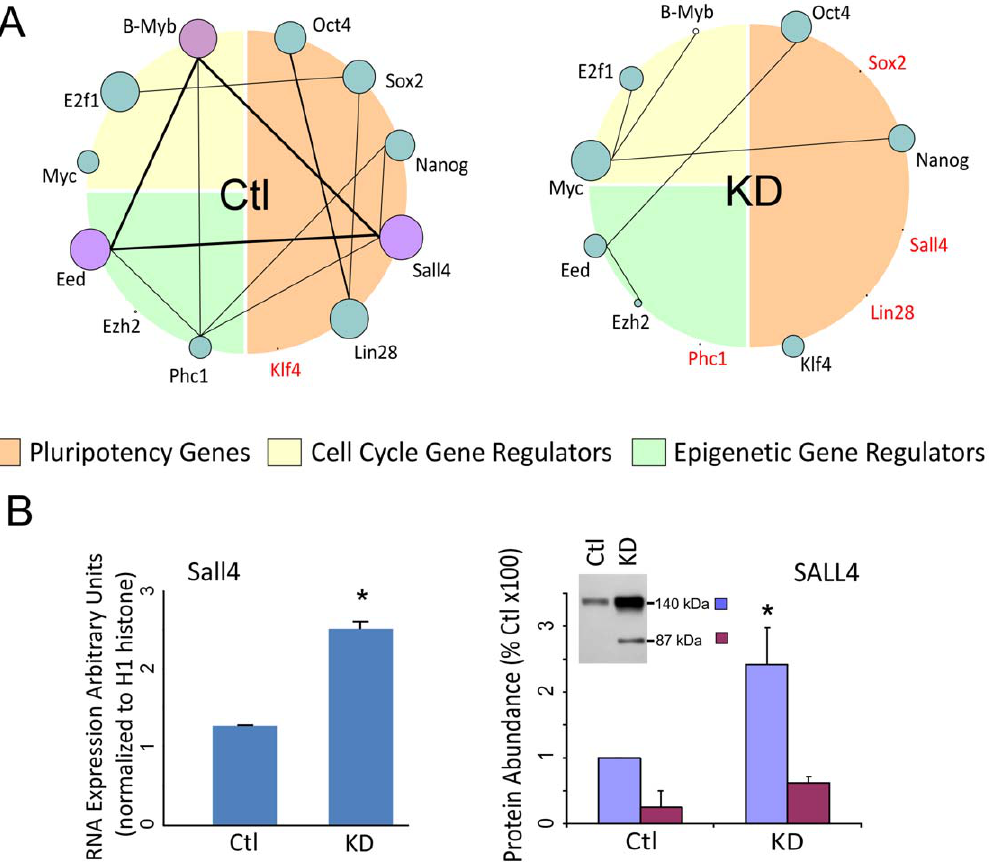
Figure 5. Global network analysis showing the distribution of connections per node in the co-expression networks. A) Interactome showing hub genes and connectivities among hubs of selected pluripotency, cell cycle and epigenetic regulator-associated genes in control (Ctl) and B-Myb knockdown (KD) cells. The size of each circle is directly proportional to the number of links (connectivity) for the indicated hub gene, and lines between genes are indicative of the number of overlapping links. As shown in this figure, B-Myb, Eed and Sall4 are major hub genes in control cells that have overlapping links with over 160 genes. Following knockdown of B-MYB, all of major hub genes either become minor hubs or lose all connectivity (shown in red). B) Based on the analysis, Sall4, a transcription factor found to be central to the control ESC network, loses all connectivity in B-MYB deficient ESCs (4A); but in response to the loss of B-MYB, Sall4 transcript and protein abundance increase significantly, suggesting that the up-regulation of this gene is a compensatory response to the loss of